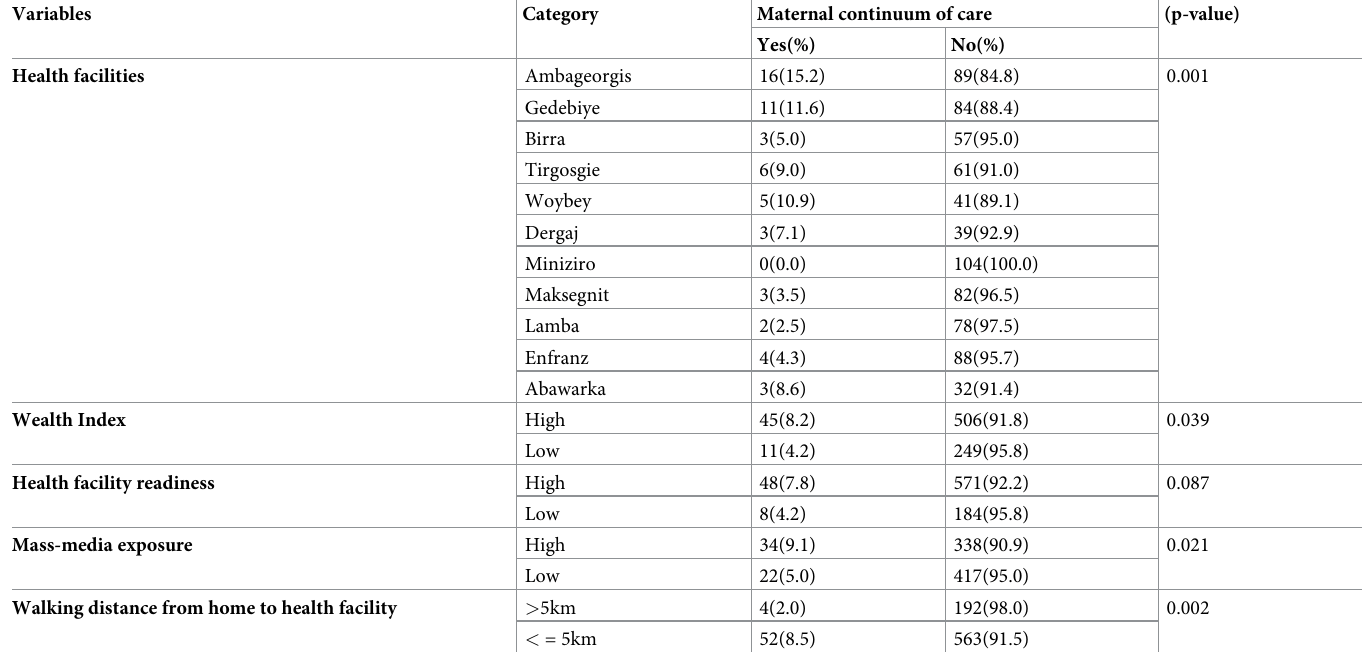
Table 2. Community level characteristics of respondents in Northwest Ethiopia, 2020 (n =